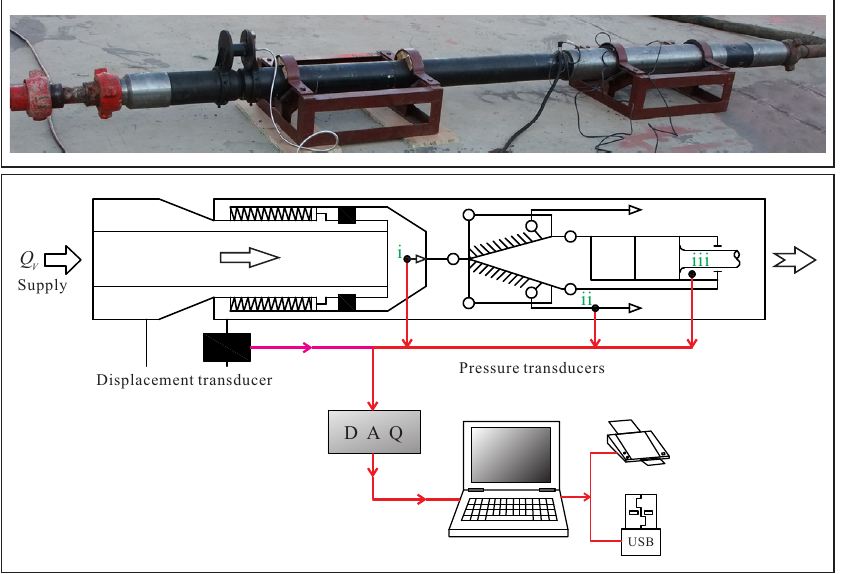
Figure 3. Schematic of the experimental system.